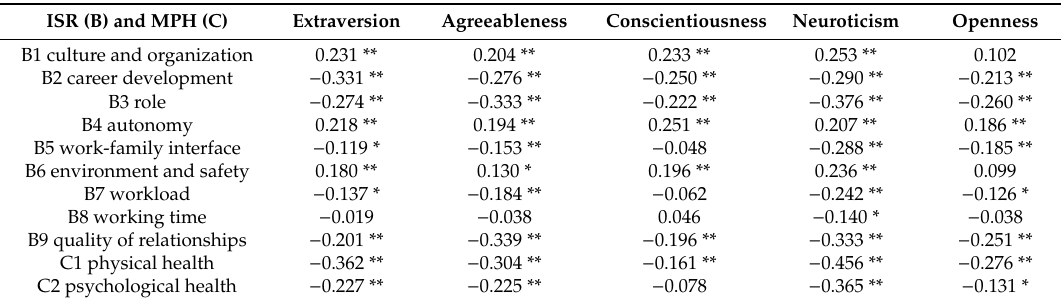
Table 1. Correlation between the Organizational and Psychosocial Risk Assessment (OPRA) and the Big Five Questionnaire